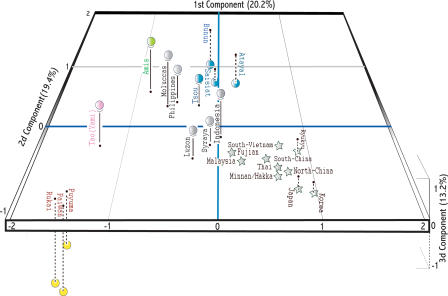
Principal Components AnalysisPrincipal components map obtained from a matrix of haplogroup frequencies in nine Taiwan indigenous tribes (Table 1), northern and southern Chinese [34], Taiwan urban population (Minnan and Hakka) [29], Japan [73], Korea [33], Luzon [12], Moluccas [14], Indonesia, Ryukyu [42] Malaysia, South Vietnam, the Philippines [20], and Thai [45,46]. Austronesian-speaking populations are represented by circles, non–Austronesian-speaking populations by stars.